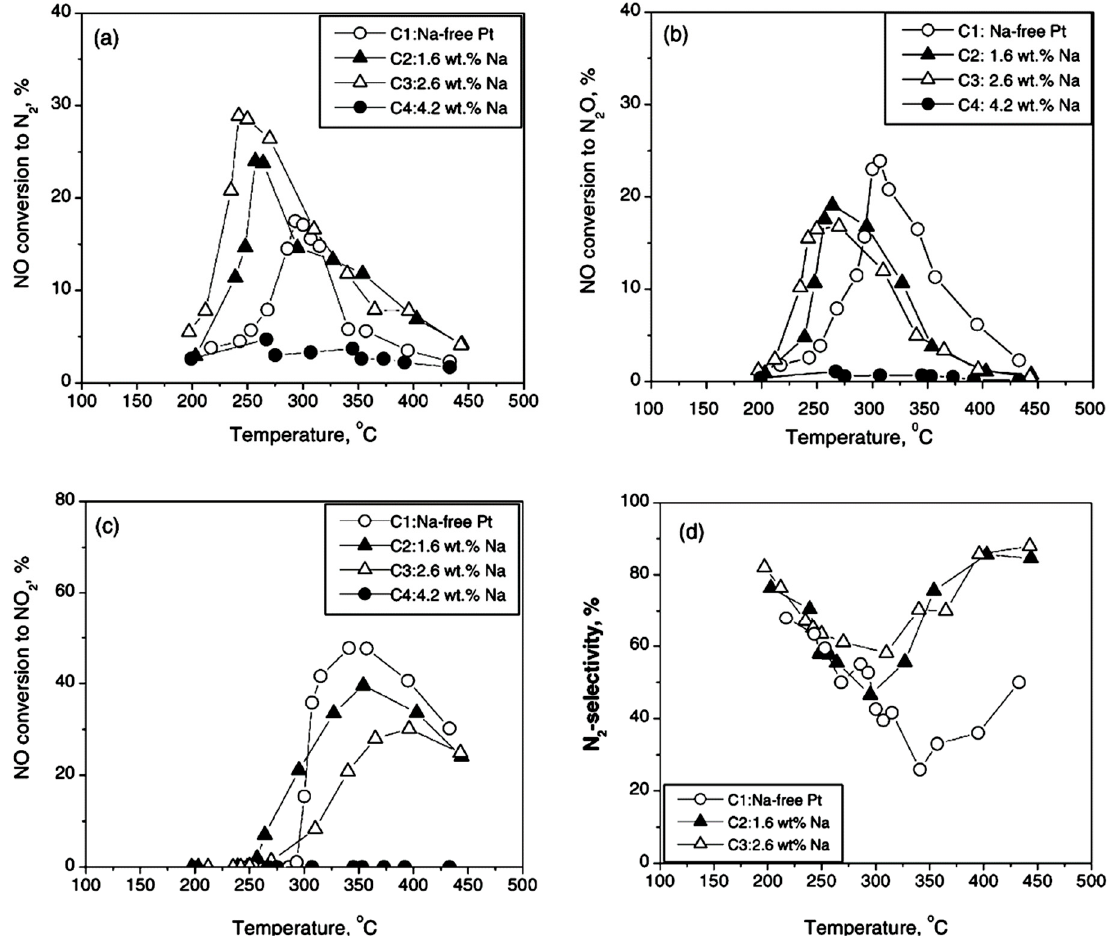
Figure 18. C 3 H 6 + NO + O 2 reaction on Na-promoted Pt/ γ -Al 2 O 3 catalysts. The effect of temperature on the conversion of NO to various N-containing products and the corresponding N 2 -selectivity: ( a ) NO conversion to N 2 ; ( b ) NO conversion to N 2 O; ( c ) NO conversion to NO 2 ; ( d ) N 2 -selectivity. Conditions: 1000 ppm NO, 1000 ppm C 3 H 6 , 5% O 2 ; reactant contact time 4 s. (Reprinted with permission from Ref. [47]; Copyright 2005, Elsevier).